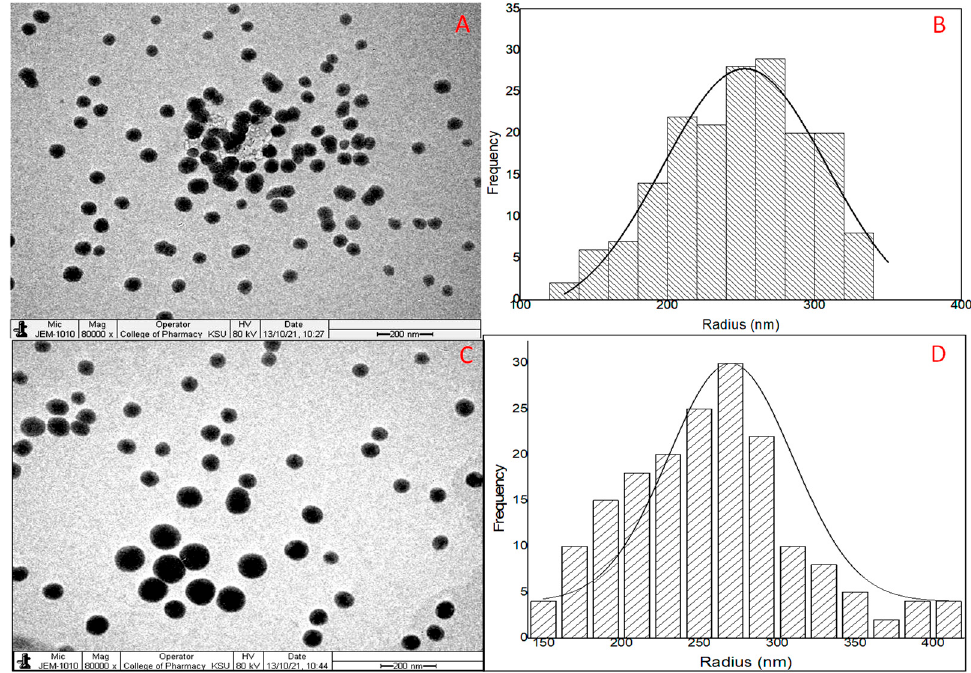
Figure 3. Apigenin bilosomes (F2): TEM image ( A ), Vesicle size distribution histogram ( B ); chitosan- coated apigenin bilosomes (F2C1): TEM image ( C ), Vesicle size distribution histogram ( D ).